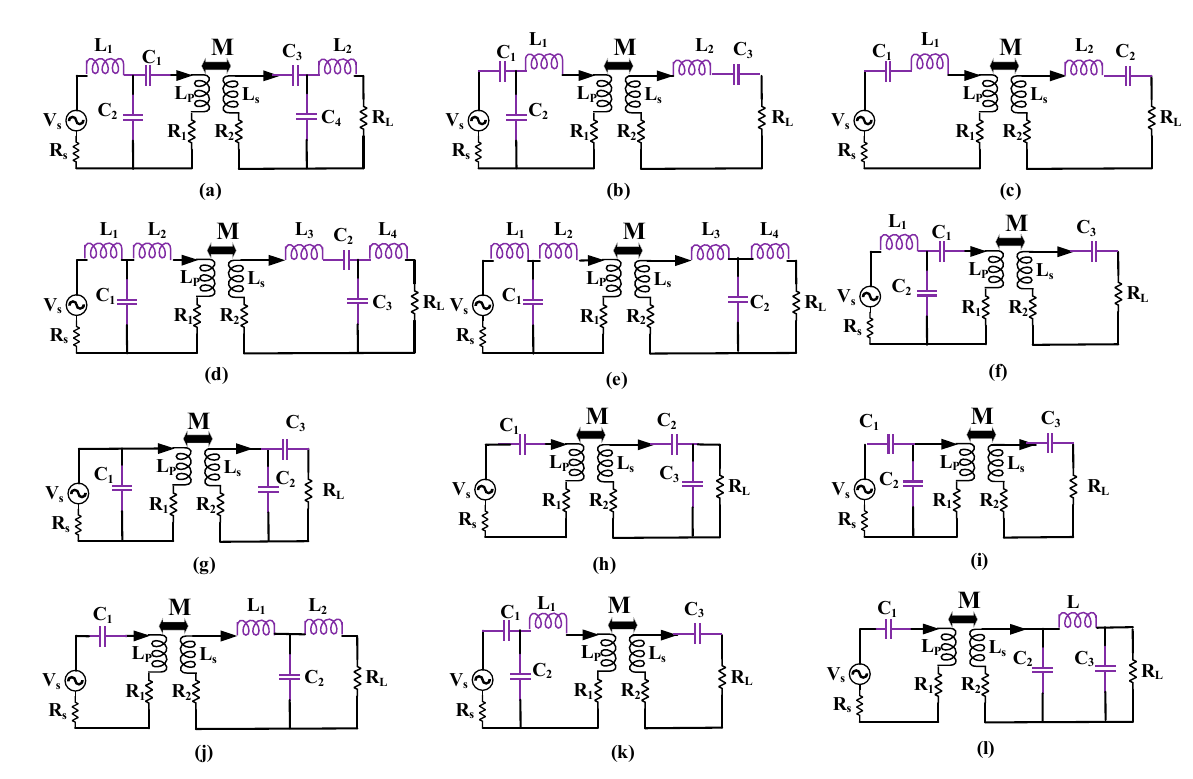
Figure 15. Hybrid compensation topologies: ( a ) LCC-LCC, ( b ) CCL-LC, ( c ) LC-LC, ( d ) LCL-LCCL, ( e ) I LCL-LCL, ( f ) LCC-S, ( g ) P-PS, ( h ) S-SP, ( i ) SP-S, ( j ) S-LCL, ( k ) CCL-S, and ( l ) S-CLC.